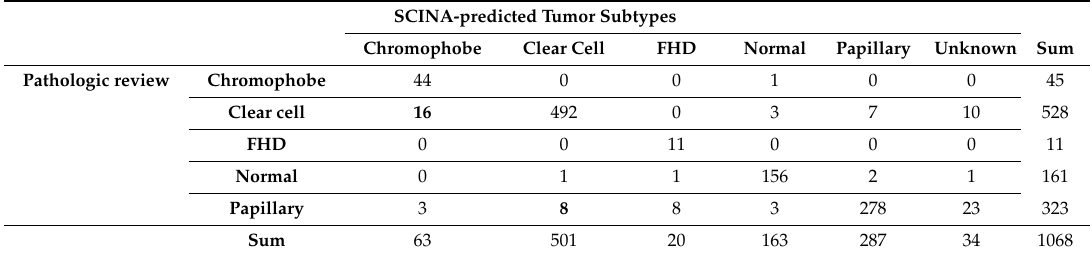
Table 1. Overlapping RCC subtypes assigned by pathological reviews and subtypes assigned by